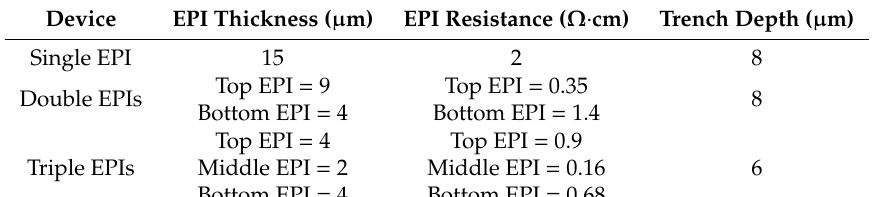
structure simulation.